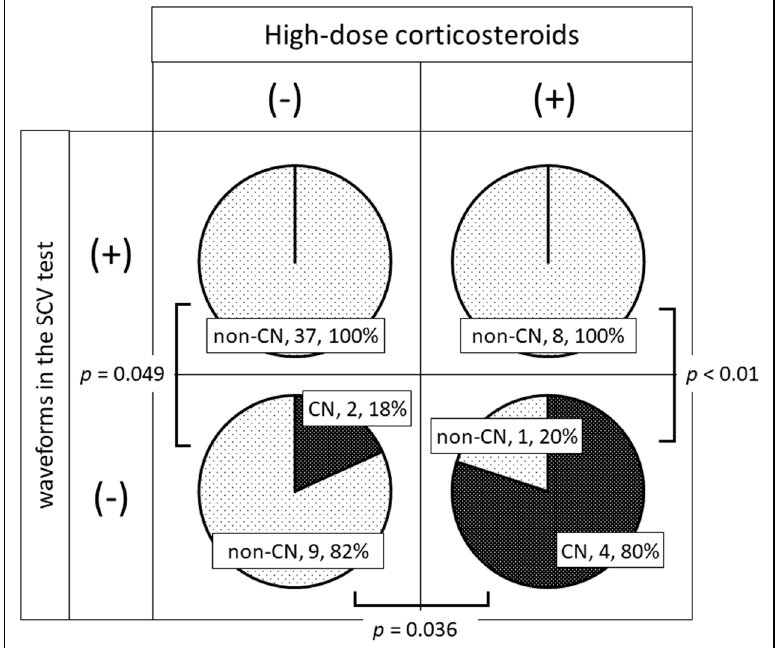
Figure 3. Comparison of incidence rates for CN based on severe peripheral neuropathy and a history of high-dose corticosteroids. No CN development was observed with or without high-dose corticosteroids in the presence of waveforms in the SCV test. In contrast, in the disappearance of the waveform in the SCV test, CN was observed in 2 of 11 patients (18%) without high-dose corticosteroids and in 4 of 5 patients (80.0%) with high-dose corticosteroids. In both instances, the frequency of onset was significantly higher in the group with visualized waveforms (with high-dose corticosteroids, p = 0.049; without high-dose corticosteroids, p < 0.01). Furthermore, the incidence rate was significantly higher when high-dose corticosteroids were used than when waveforms were not visualized in the SCV test ( p = 0.036). CN, Charcot neuroarthropathy; SCV, sensory nerve conduction velocity.